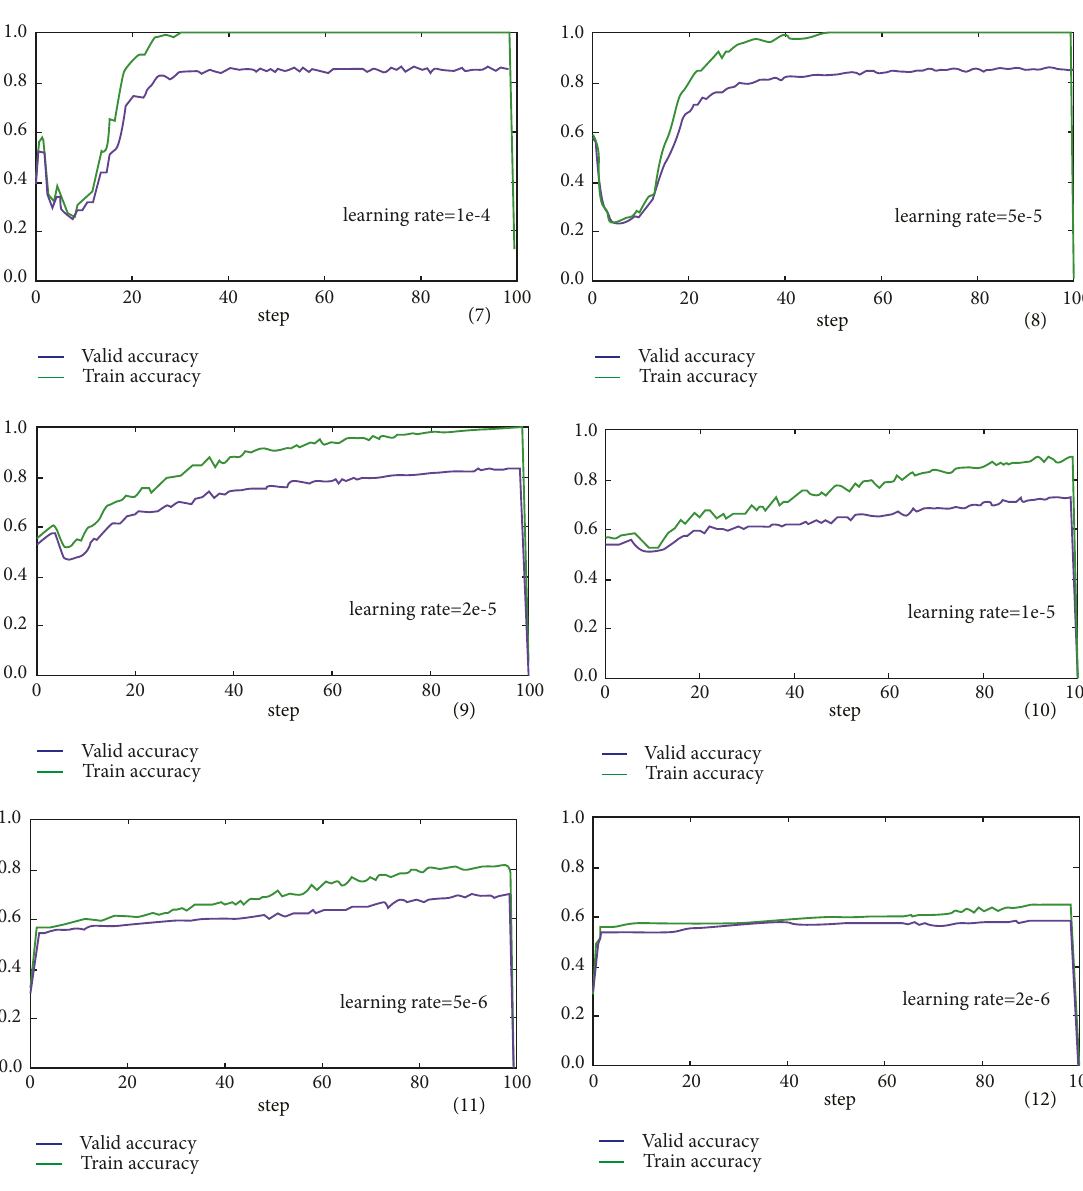
Figure 12: Changes of correct rate under different learning rates in training process